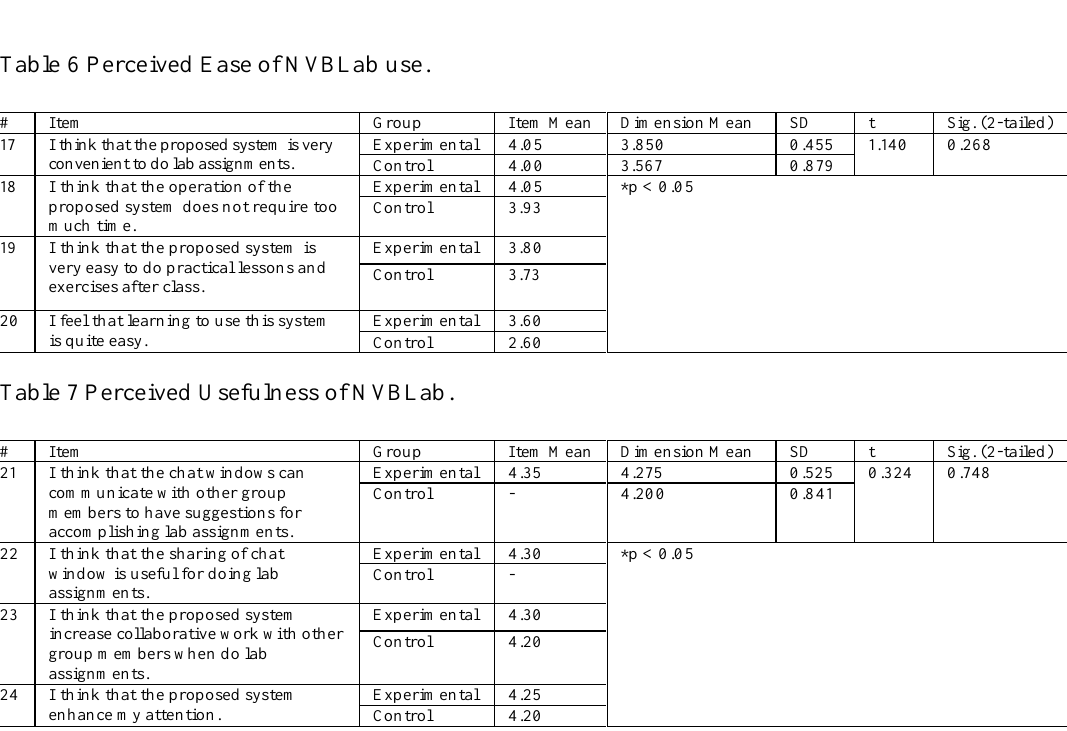
Table 8 Attitude toward using NVBLab.